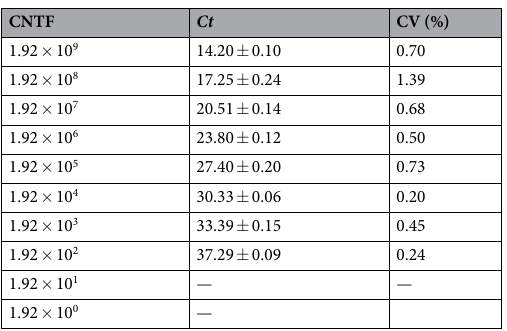
— — — Table 2. The sensitivity and reproducibility of TaqMan RQ-PCR. Values presented as mean ± SD (N = 3). The assay was evaluated using 10-fold serial dilution of all stock plasmids ranging from 1.92 × 10 9 to 1.92 × 10 0 copies/ µ L. Ct stands for RQ-PCR cycle number where fluorescence curve crosses threshold line. CV stands for coefficients of variation.